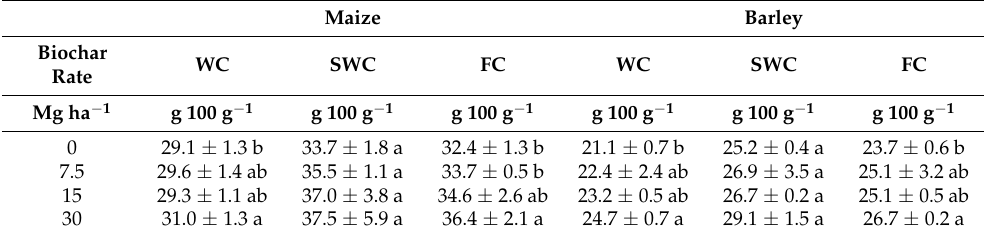
Table 2. Parameters of soil water content (WC), saturated water capacity (SWC) and field capacity (FC) measured in October 2015 and March 2016 by ring–cutting method after maize and barley harvest. Maize Barley Biochar WC SWC FC WC SWC Rate